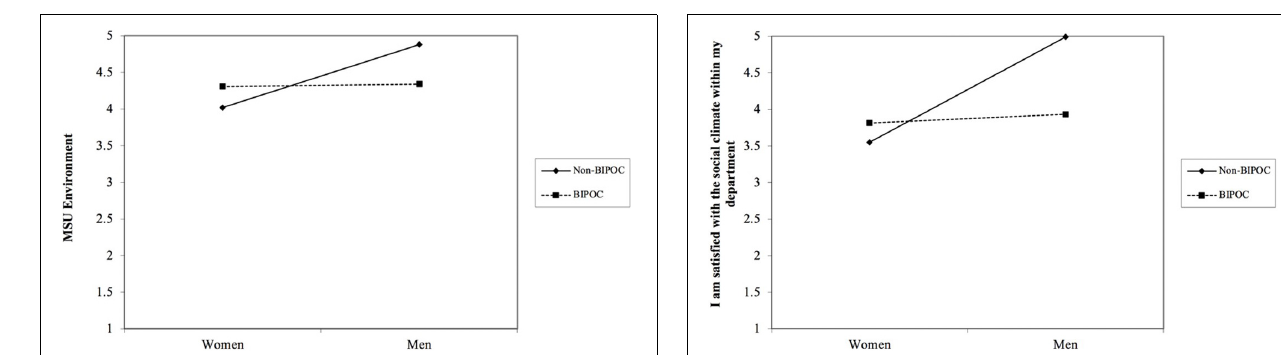
FIGURE 4 | Gender interacting with BIPOC to predict MSU environment item “I am satisfied with the social climate within my department.”